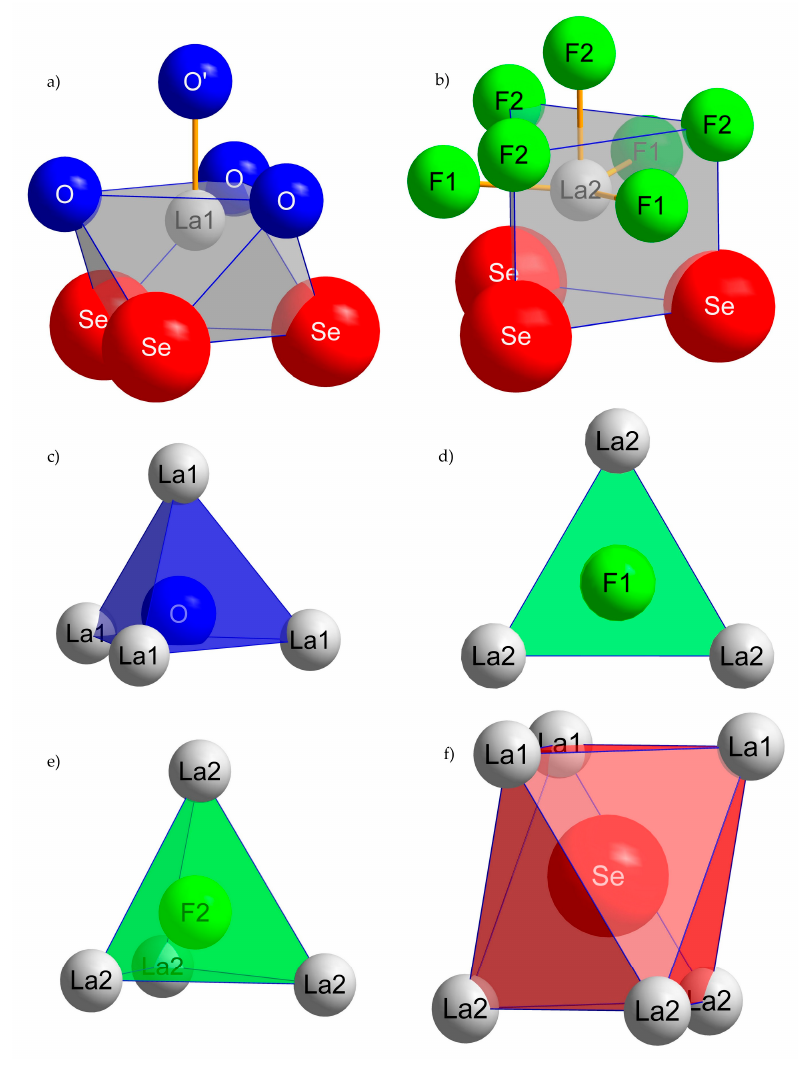
Figure 2. Coordination polyhedra in A-type La 2 OF 2 Se.